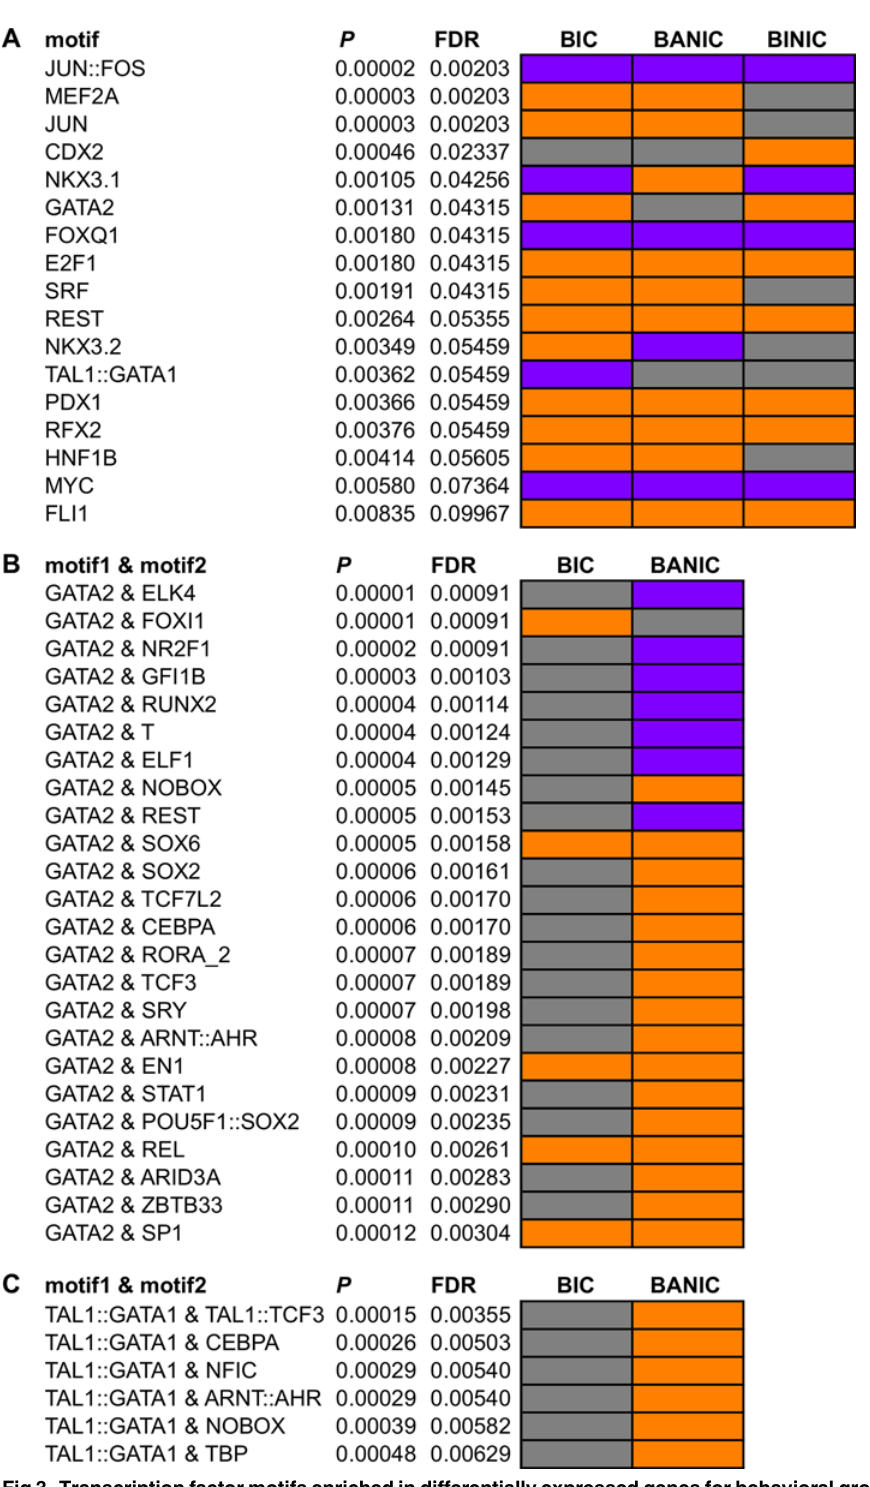
PLOS ONE | DOI:10.1371/journal.pone.0145801 December 29,